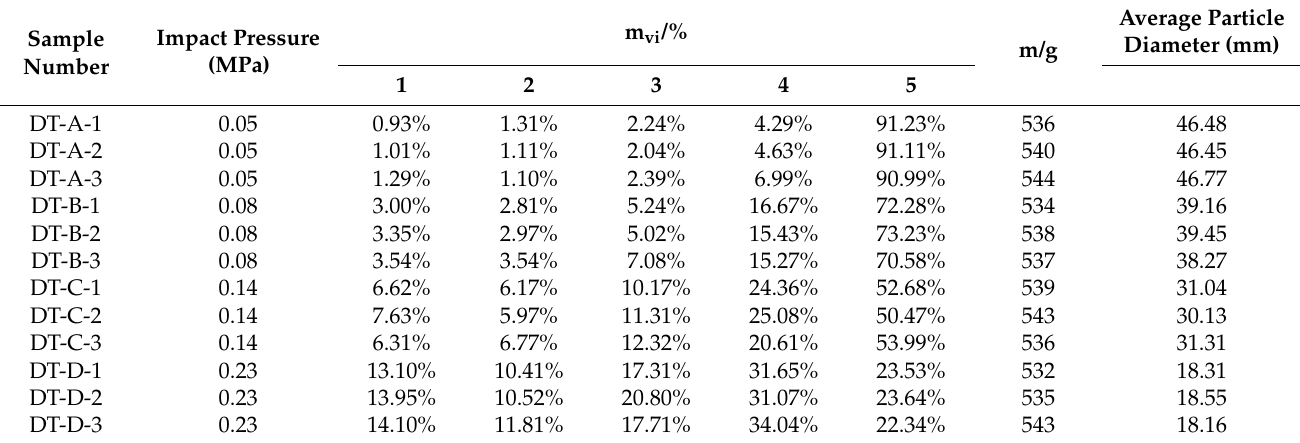
Figure 5. The sample debris after loading: ( a ) photo of the typical distribution of the sample debris; ( b ) figure of variation of the particle size. Table 2. The quality percentage of each grade of sample